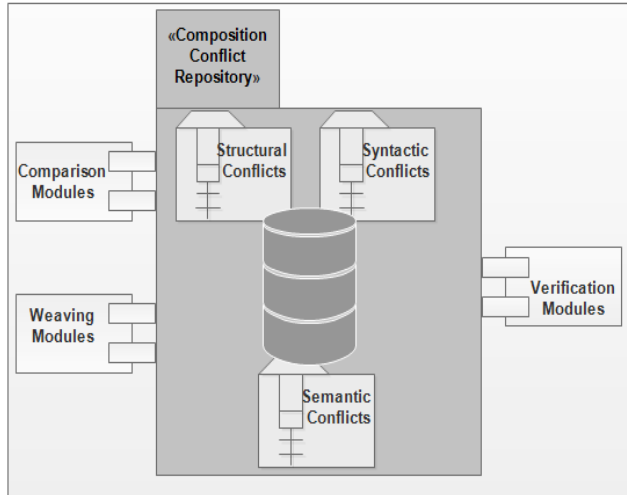
Fig. 2. A graphical concept of the composition conflict